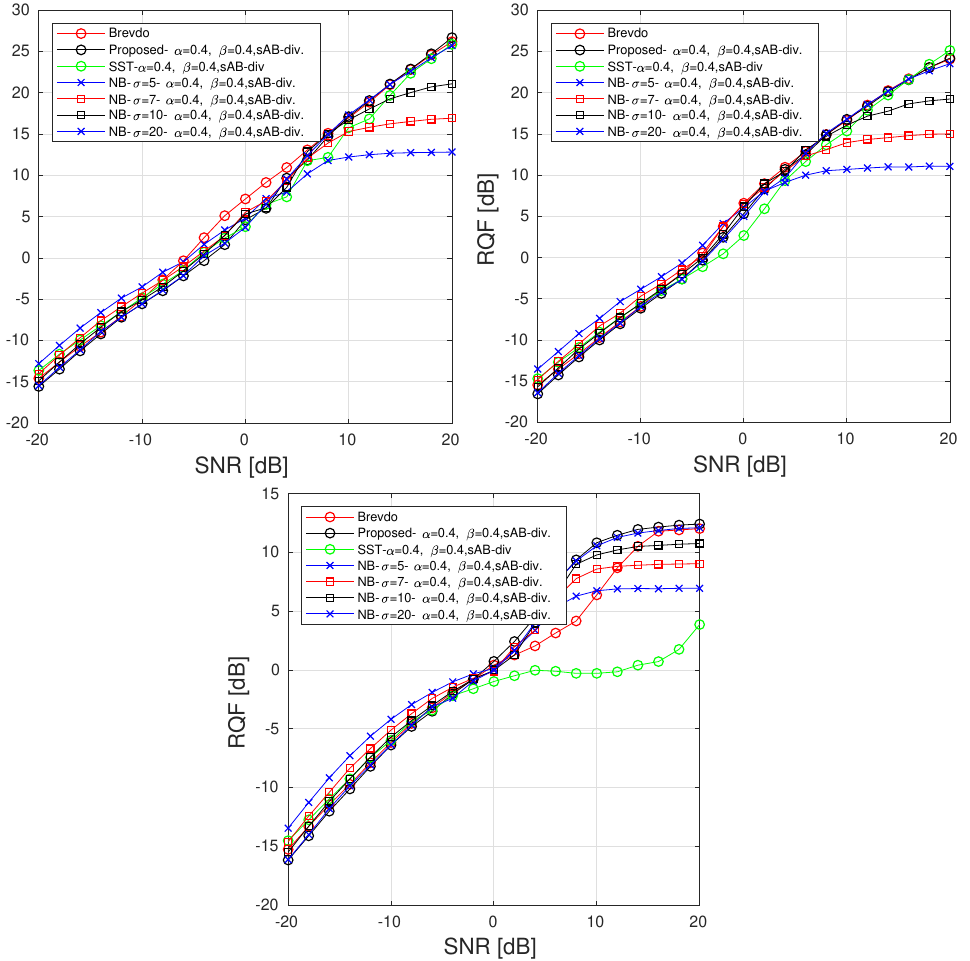
Figure 10. RQF obtained for each component in Figure 4 using compared methods for various SNRs with L = 20. The results are averaged over 100 realizations of noise